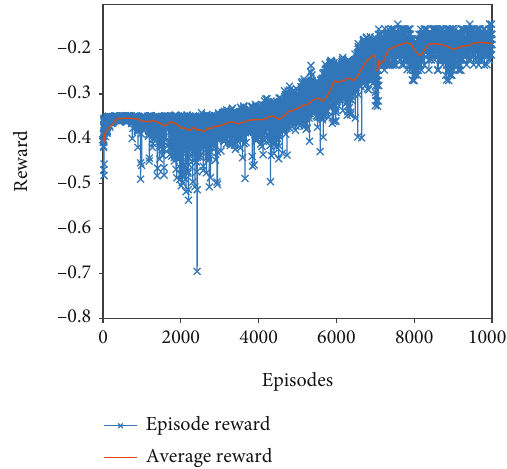
Figure 9: The response of episode reward.